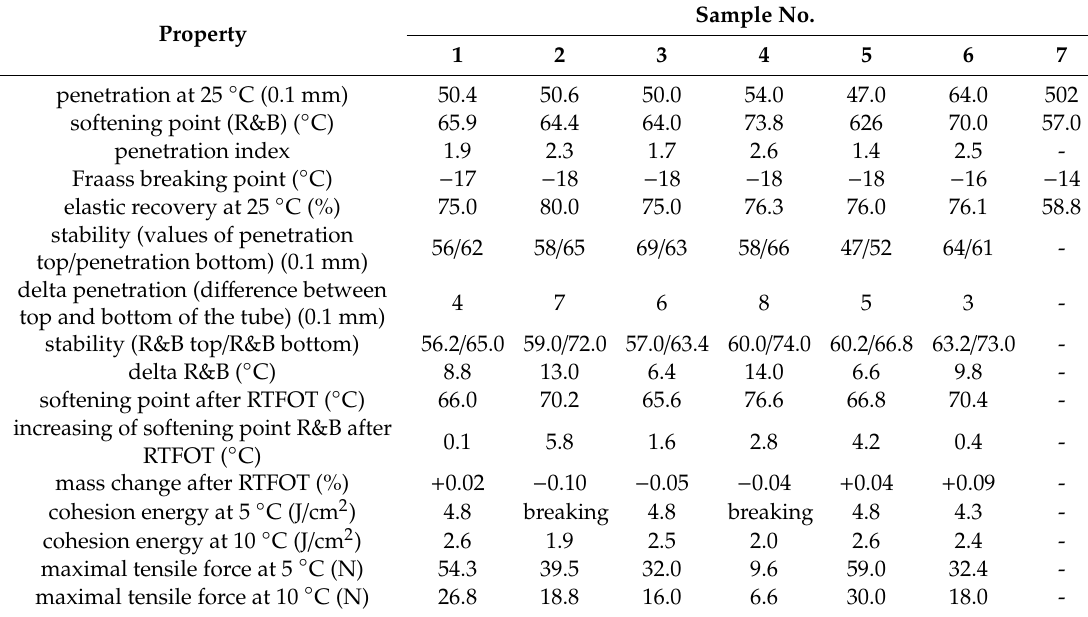
Table 3. Properties of bitumen modified at 190 ◦